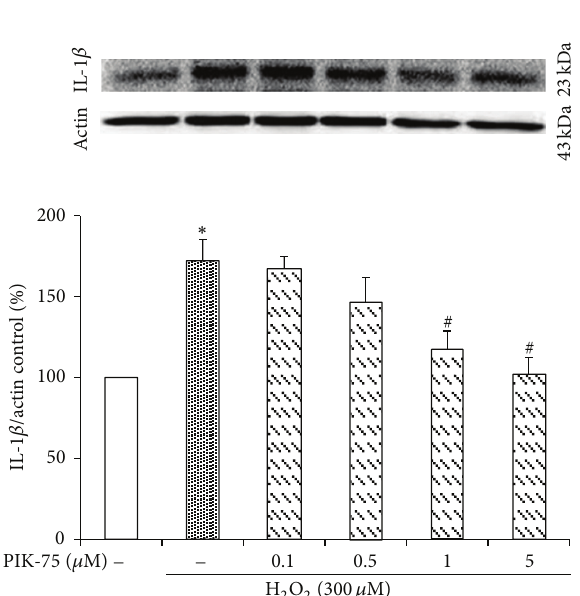
Figure 6: Effect of PIK-75 on IL-1 𝛽 expression in feline EECs stimulated by H 2 O 2 . Serum-starved EECs were preincubated in the presence of PIK-75. EECs were then stimulated with H 2 O 2 (300 𝜇 M, 6 hours). The expression of IL-1 𝛽 was estimated by Western blot analysis. Data are expressed as means ± S.E of four experiments (Student’s t -test; ∗ 𝑃 < 0.05 versus control, # 𝑃 < 0.05 versus H 2 O 2 alone).